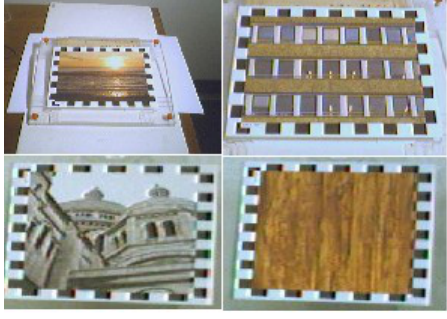
Figure 4. An example of UCSB dataset.